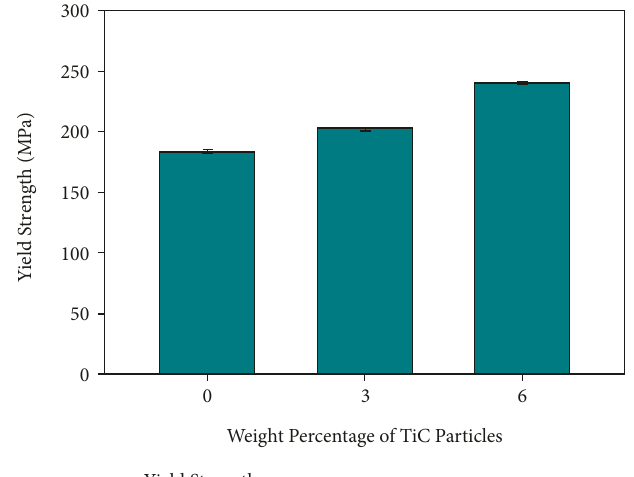
Figure 9: Yield strength of Al7075 alloy with TiC composites.